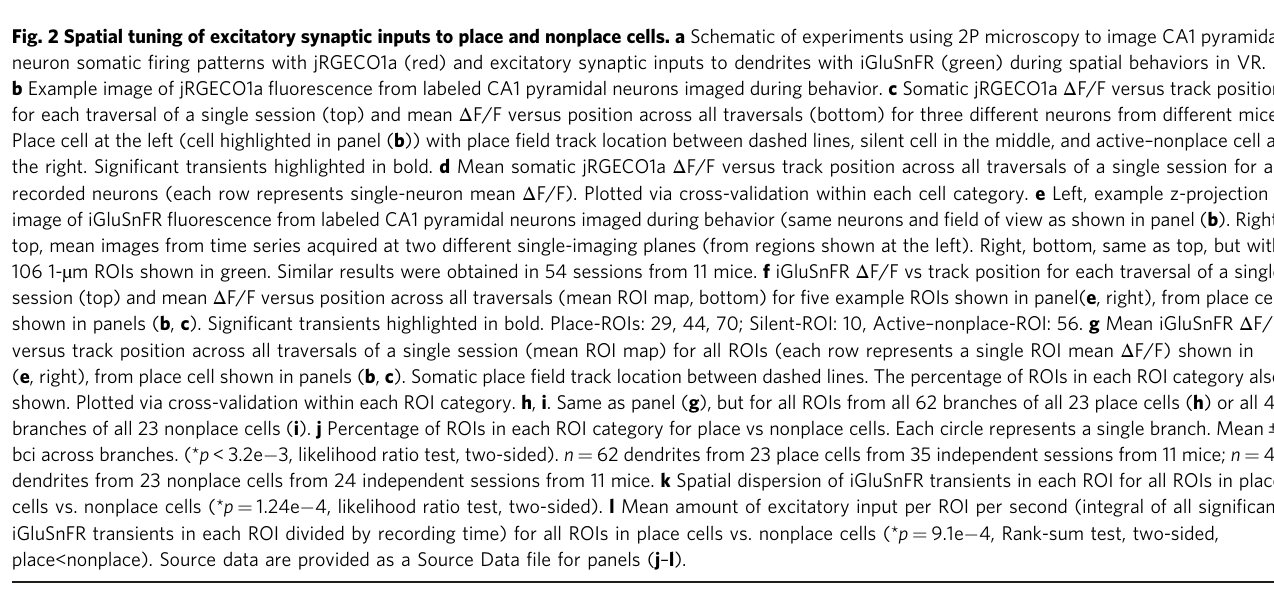
Fig. 2 Spatial tuning of excitatory synaptic inputs to place and nonplace cells. a Schematic of experiments using 2P microscopy to image CA1 pyramidal neuron somatic fi ring patterns with jRGECO1a (red) and excitatory synaptic inputs to dendrites with iGluSnFR (green) during spatial behaviors in VR. b Example image of jRGECO1a fl uorescence from labeled CA1 pyramidal neurons imaged during behavior. c Somatic jRGECO1a Δ F/F versus track position for each traversal of a single session (top) and mean Δ F/F versus position across all traversals (bottom) for three different neurons from different mice. Place cell at the left (cell highlighted in panel ( b )) with place fi eld track location between dashed lines, silent cell in the middle, and active – nonplace cell at the right. Signi fi cant transients highlighted in bold. d Mean somatic jRGECO1a Δ F/F versus track position across all traversals of a single session for all recorded neurons (each row represents single-neuron mean Δ F/F). Plotted via cross-validation within each cell category. e Left, example z-projection image of iGluSnFR fl uorescence from labeled CA1 pyramidal neurons imaged during behavior (same neurons and fi eld of view as shown in panel ( b ). Right, top, mean images from time series acquired at two different single-imaging planes (from regions shown at the left). Right, bottom, same as top, but with 106 1- µ m ROIs shown in green. Similar results were obtained in 54 sessions from 11 mice. f iGluSnFR Δ F/F vs track position for each traversal of a single session (top) and mean Δ F/F versus position across all traversals (mean ROI map, bottom) for fi ve example ROIs shown in panel( e , right), from place cell shown in panels ( b , c ). Signi fi cant transients highlighted in bold. Place-ROIs: 29, 44, 70; Silent-ROI: 10, Active – nonplace-ROI: 56. g Mean iGluSnFR Δ F/F versus track position across all traversals of a single session (mean ROI map) for all ROIs (each row represents a single ROI mean Δ F/F) shown in ( e , right), from place cell shown in panels ( b , c ). Somatic place fi eld track location between dashed lines. The percentage of ROIs in each ROI category also shown. Plotted via cross-validation within each ROI category. h , i . Same as panel ( g ), but for all ROIs from all 62 branches of all 23 place cells ( h ) or all 41 branches of all 23 nonplace cells ( i ). j Percentage of ROIs in each ROI category for place vs nonplace cells. Each circle represents a single branch. Mean ± bci across branches. (* p < 3.2e − 3, likelihood ratio test, two-sided). n = 62 dendrites from 23 place cells from 35 independent sessions from 11 mice; n = 41 dendrites from 23 nonplace cells from 24 independent sessions from 11 mice. k Spatial dispersion of iGluSnFR transients in each ROI for all ROIs in place cells vs. nonplace cells (* p = 1.24e − 4, likelihood ratio test, two-sided). l Mean amount of excitatory input per ROI per second (integral of all signi fi cant iGluSnFR transients in each ROI divided by recording time) for all ROIs in place cells vs. nonplace cells (* p = 9.1e − 4, Rank-sum test, two-sided, place<nonplace). Source data are provided as a Source Data fi le for panels ( j – l